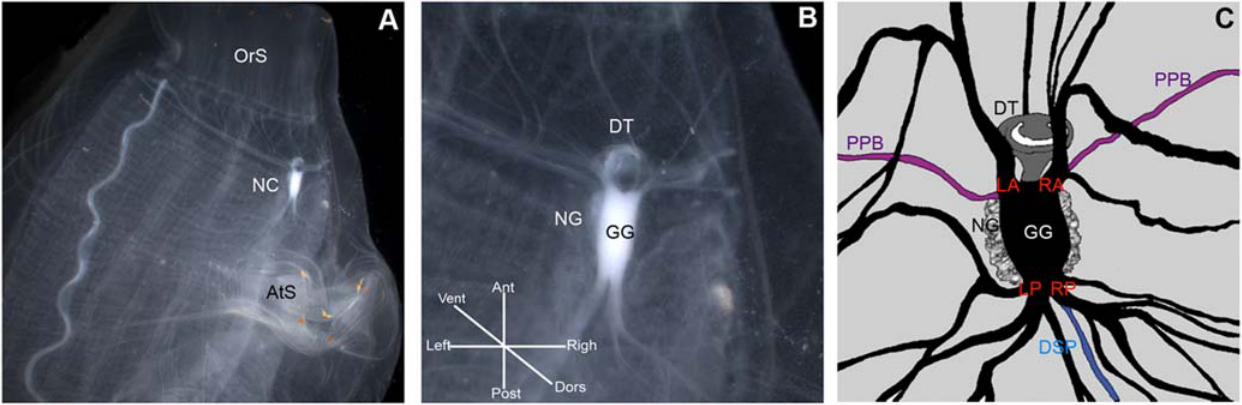
Figure 1. Ciona neural complex anatomy. A Neural complex (NC) of a wild-type animal, located between the oral siphon (OrS) and the atrial siphon (AtS). B Higher magnification of the neural complex (NC) composed of the neural ganglion (GG), the neural gland (NG) and the dorsal tubercle (DT). C Nomenclature used to name the nerves emerging from the ganglion. Peripharyngeal band (PPB), left anterior nerve (LA), right anterior nerve (RA), left posterior nerve (LP), right posterior nerve (RP), dorsal strand plexus (DSP).